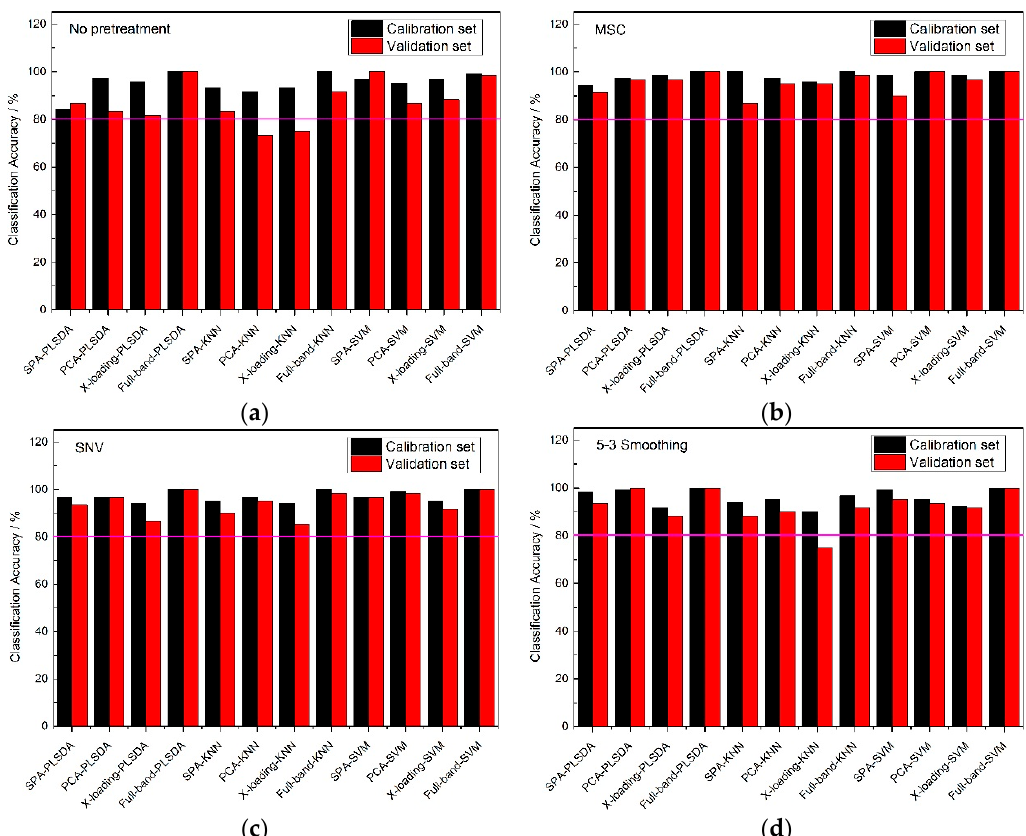
Figure 5. The classification accuracy results of Haihe78 with ( a ) no pretreatment method, ( b ) the MSC pretreatment method, ( c ) the SNV pretreatment method and ( d ) the 5-3 smoothing pretreatment